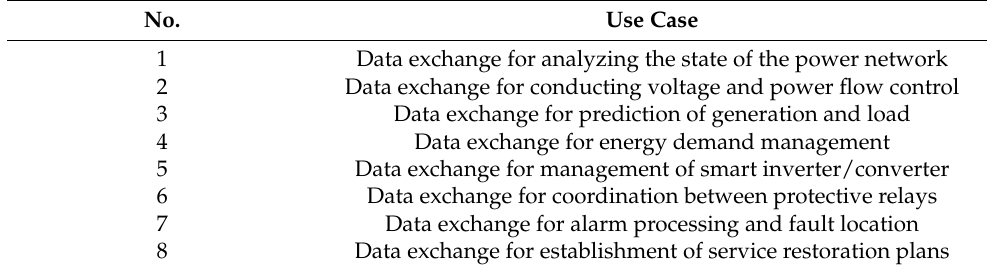
Table 1. List of the use cases for the carbon-free island MG. No. Use Case